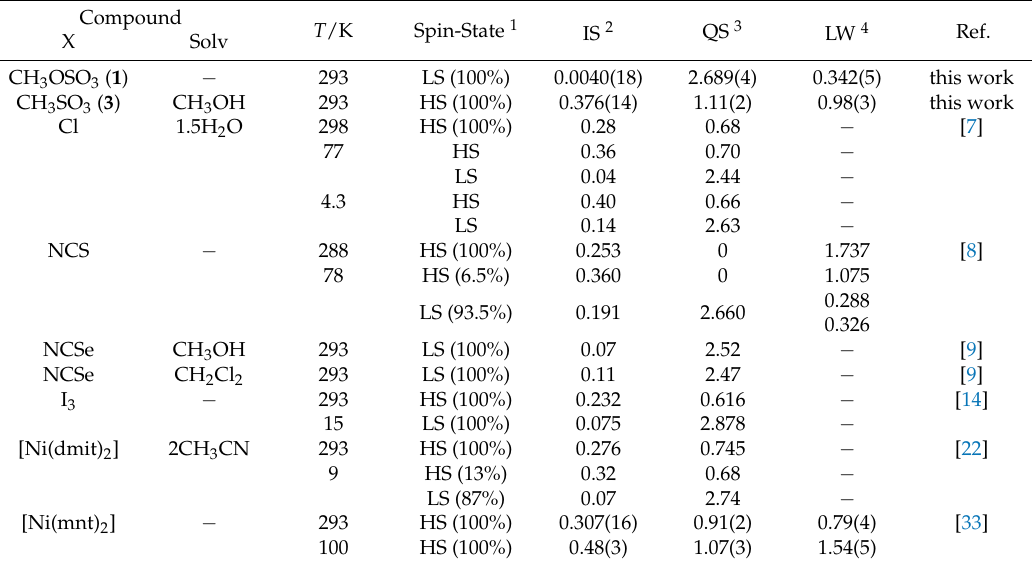
Figure 4. Mössbauer spectra for 1 ( a ) and 3 ( b ) at 293 K. Gray circles are recorded data points. The blue and red curves are fitted LS and HS spectra, respectively. Table 1. Mössbauer parameters (mm s − 1 ) for [Fe(qsal) 2 ](X)·solv